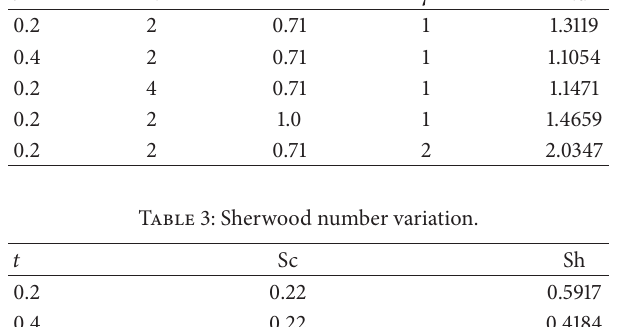
Figure 7. Four different values of Schmidt number Sc = 0.22, 0.62, 0.78, and 0.94 are chosen. They physically